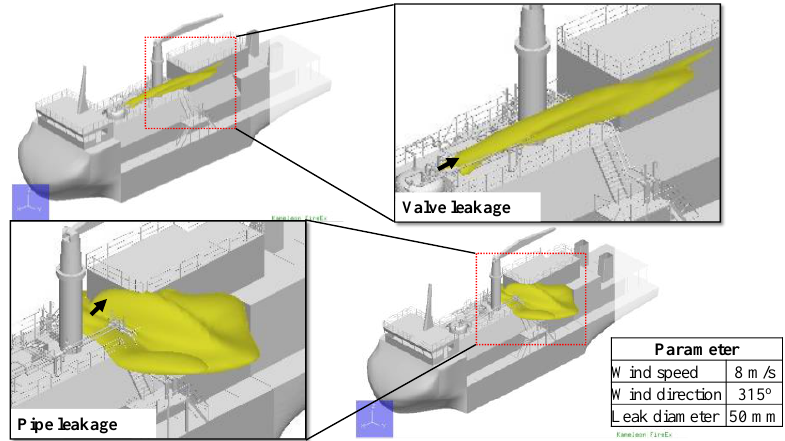
Figure 17. Typical gas cloud formation of gas release from valve and pipe.